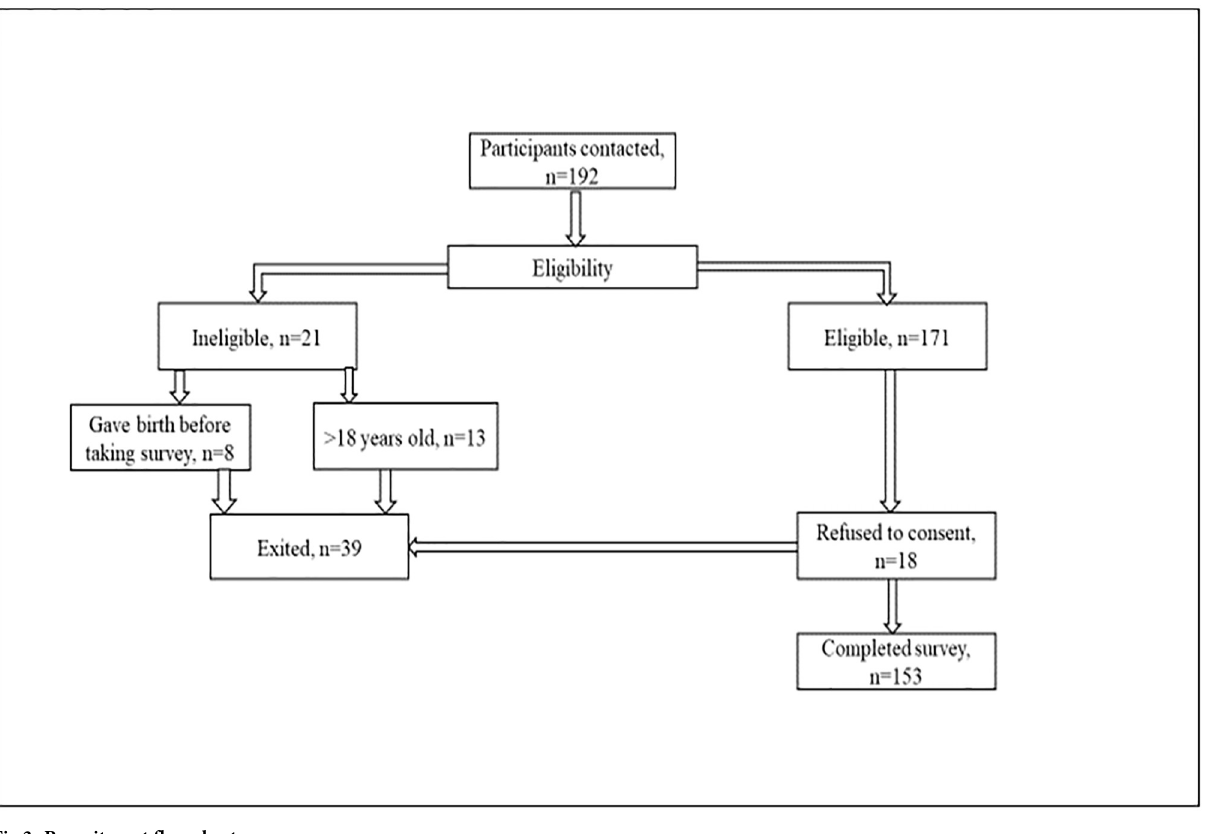
Fig 3. Recruitment flow